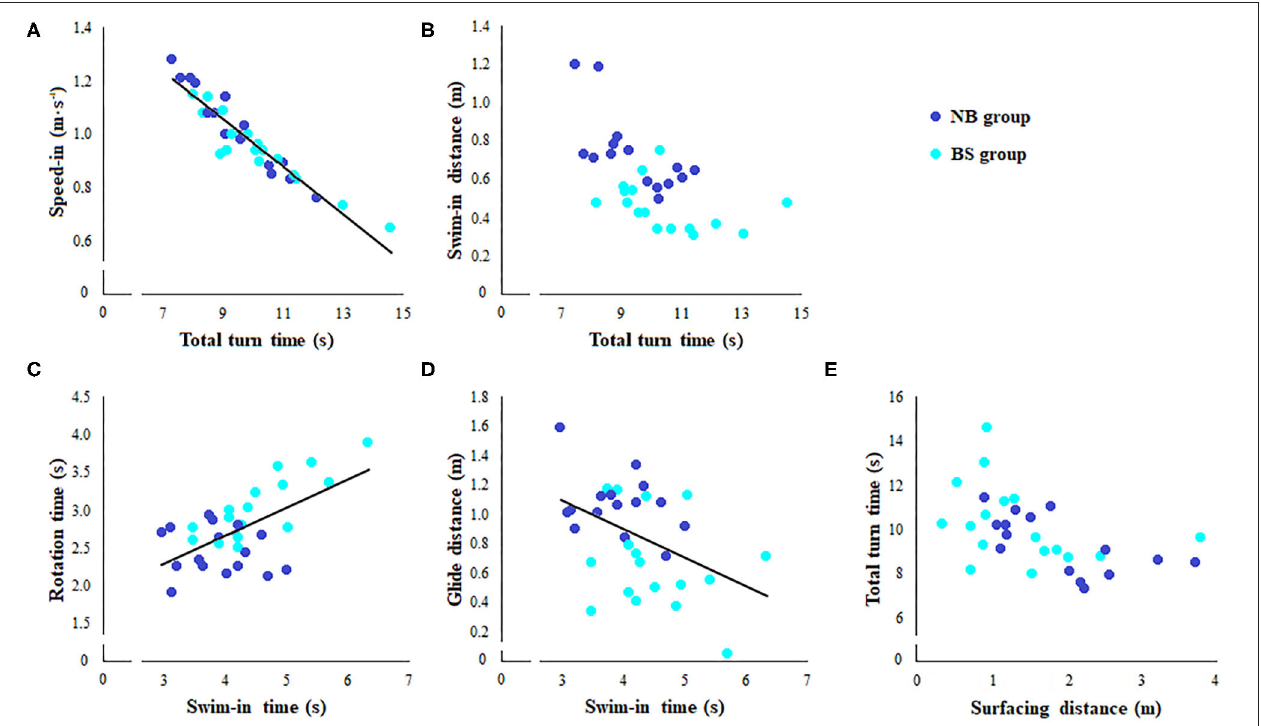
FIGURE 2 | Relationships between kinematic parameters of the different turn phases for No Breath (NB—dark blue circles) and Breath Stroke (BS—light blue circles) groups’ data. Each circle represents a single subject. When present, the line refers to linear regression analysis computed on the data of the two groups pooled together. (A) Speed-in vs. total turn time; (B) swim-in distance vs. total turn time; (C) rotation time vs. swim-in time; (D) glide distance vs. swim-in time; (E) surfacing distance vs. total turn time.